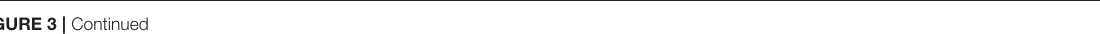
and STRUCTURE came from group 5. The fifth group